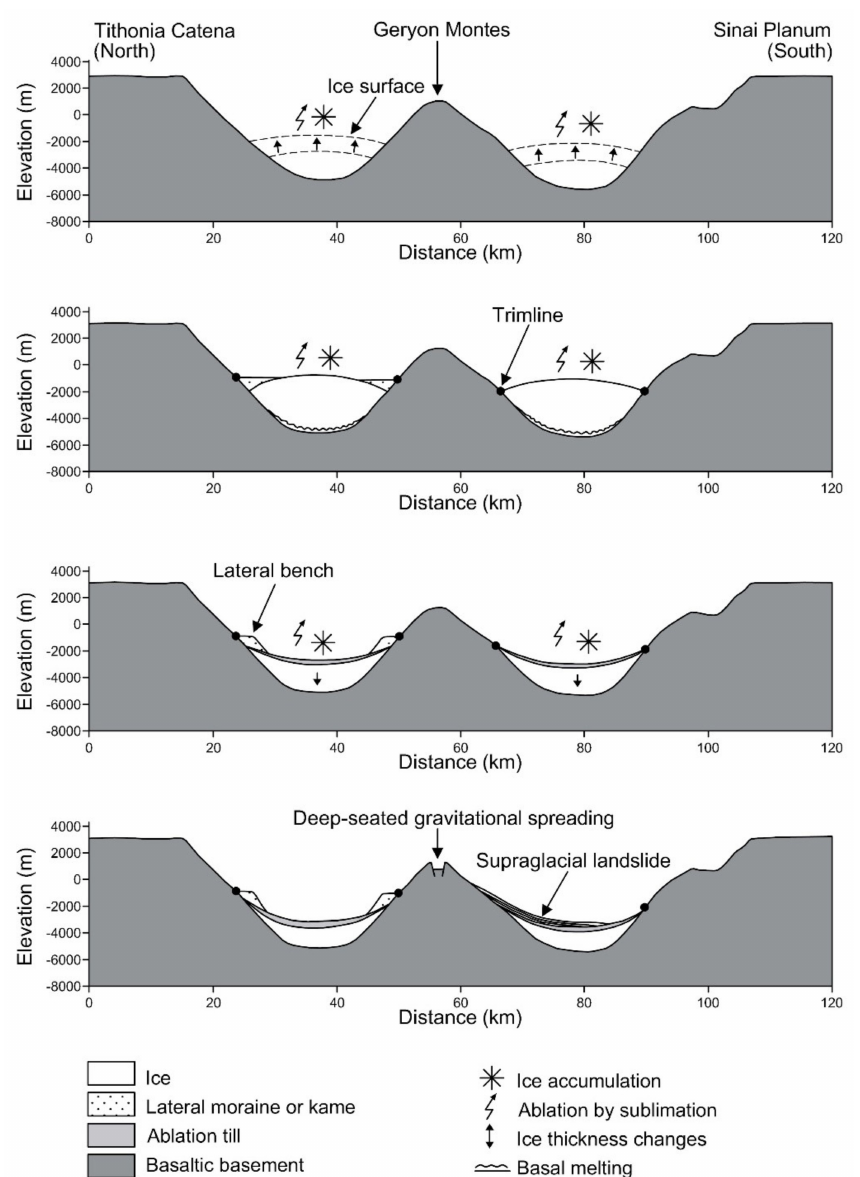
Figure 9. Proposed scenario for Valles Marineris glaciation along cross-section in Ius Chasma; redrawn after Gourronc et al. [61]. The sketch shows the glacial thickening and thinning, with the formation of trimlines, lateral benches, and ablation tills. As in alpine environment on Earth, the glacial retreat and the relative slope debuttressing favor the formation of DSGSD phenomena and supraglacial